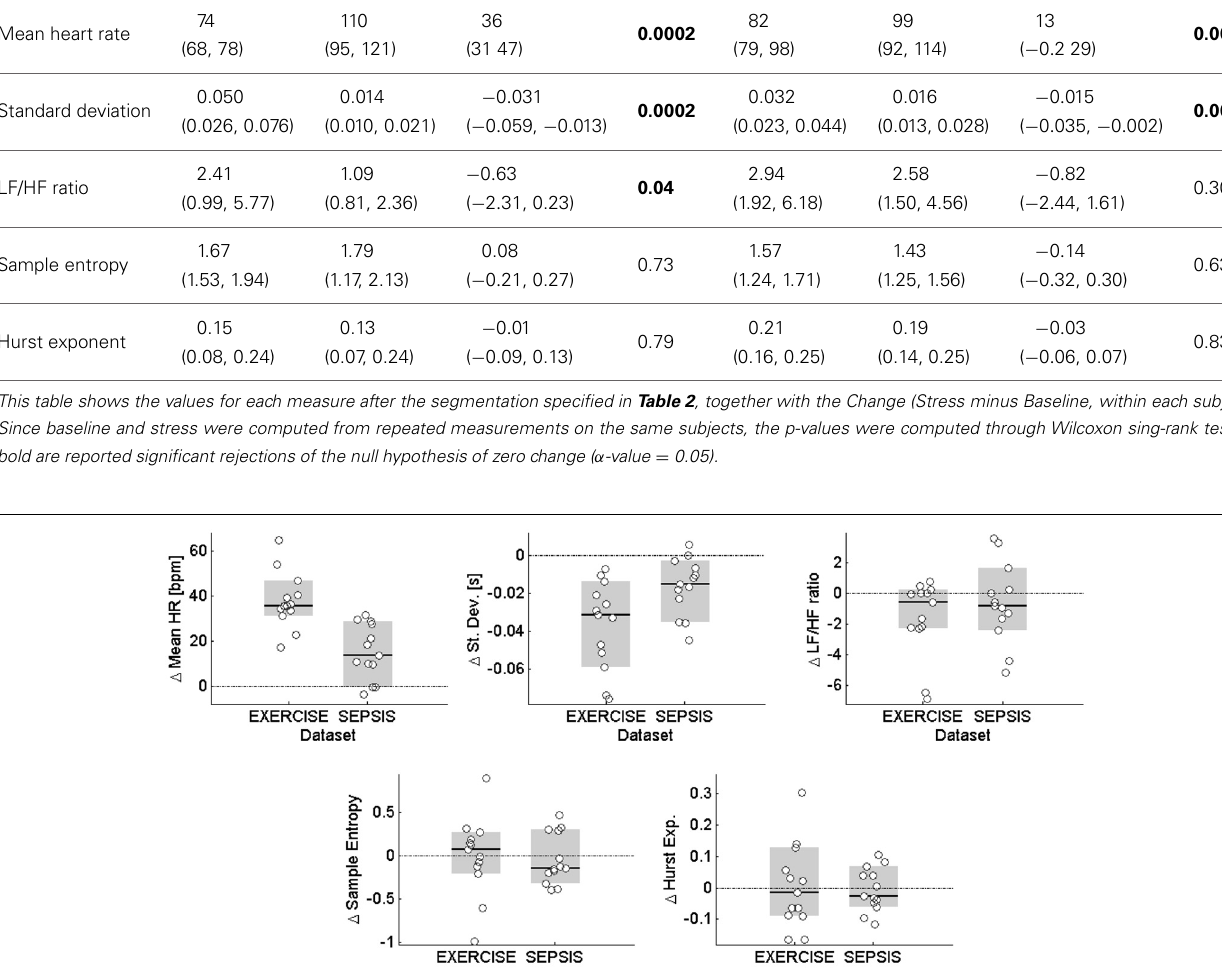
measures of HRV. Each white circle represents the change in the median variability of a given subject from baseline to stress, as